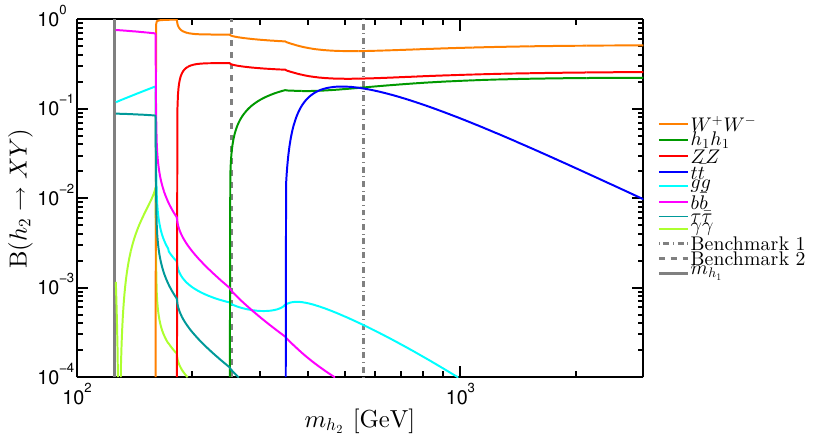
Figure 8 . Branching ratios for h 2 as a function of its mass. When the channels are open, the main decay modes are h 2 ! WW and h 2 ! ZZ